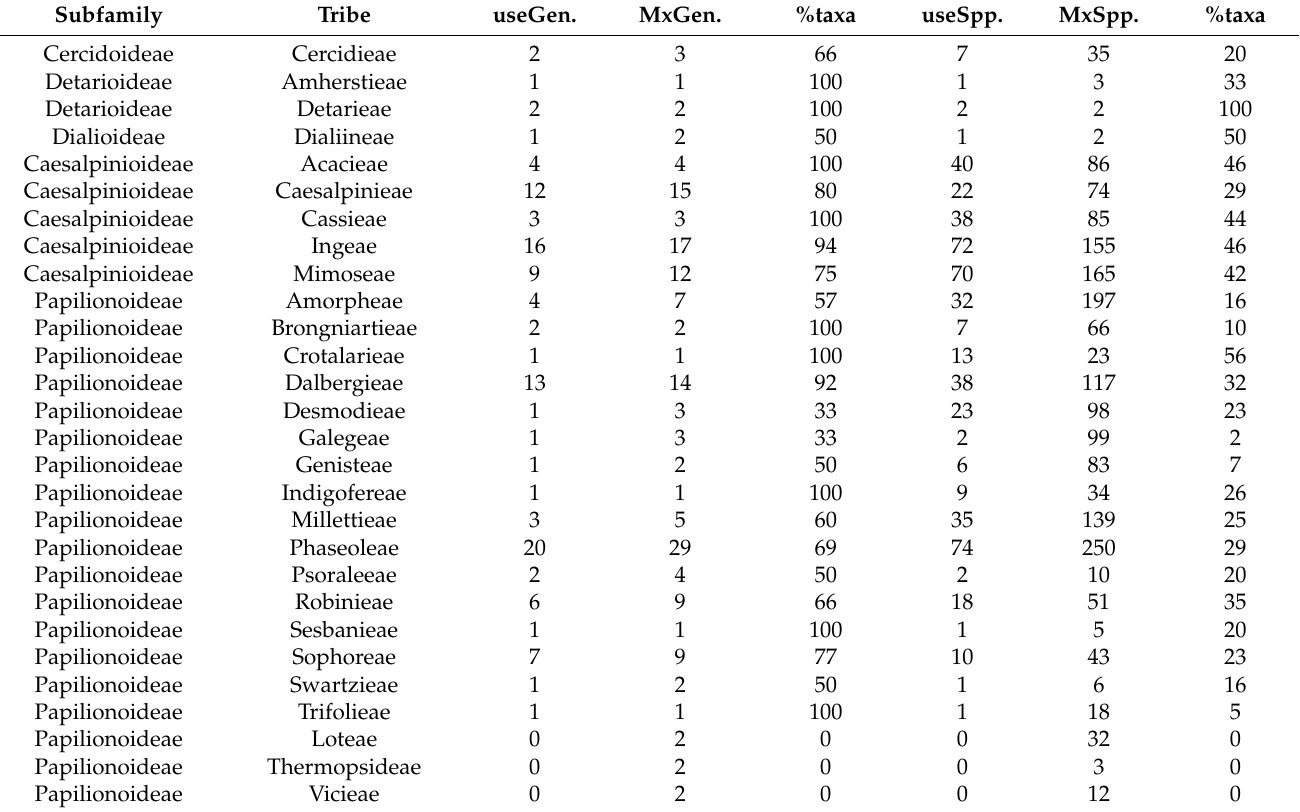
Table 1. Taxonomic distribution of useful native taxa amongst tribes of the five subfamilies: Cercidoideae, Detarioideae, Dialioideae, Caesalpinioideae and Papilionoideae, showing the total numbers of Mexican and their useful records. Abbrevi- ations stand for use = useful taxa, Mx = Mexican taxa, Gen. = genera and Spp. = species. A total of 115 genera (72.7%) and 525 species (27.7%) are reported useful at the National Herbarium